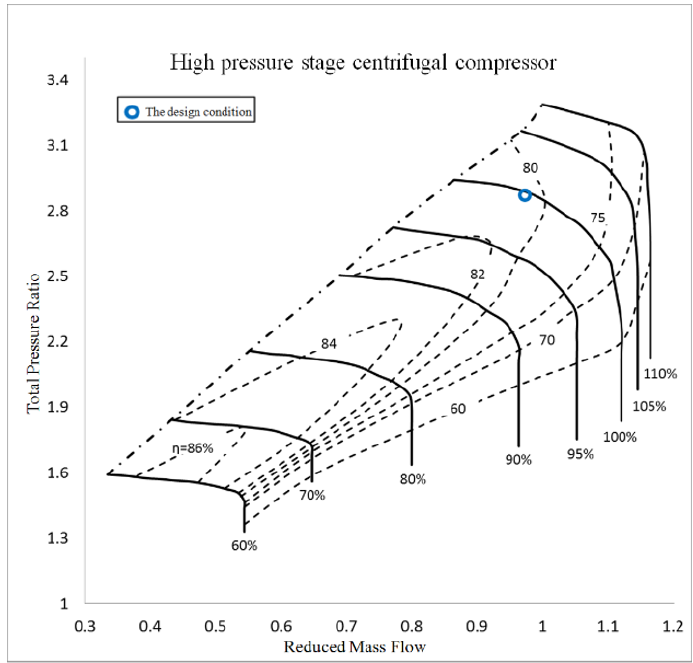
Figure 6. Performance curve of the high-pressure-stage centrifugal compressor.